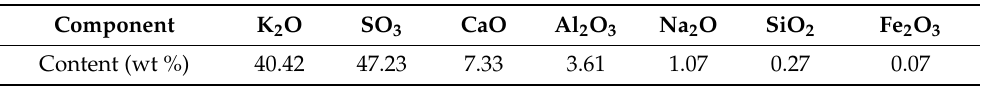
Figure 4. XRD patterns of the crystallized product of lixivium from the calcined products at 700 °C (CaO/alunite = 0.2). Table 1. X-ray fluorescence (XRF) analysis of the crystallized product of lixivium from the calcined products (CaO/alunite = 0.2) (in oxide form). Component